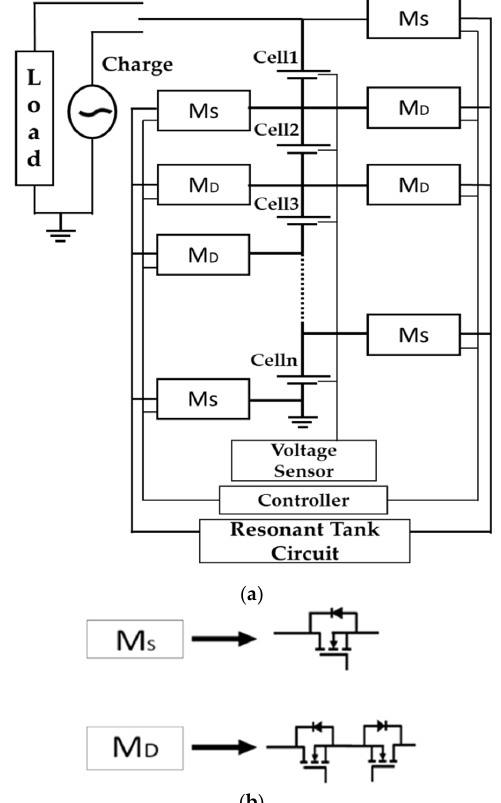
Figure 3. Proposed single resonant converter-based cell-balancing circuit. ( a ) circutit structure; ( b ) switch configaretion.